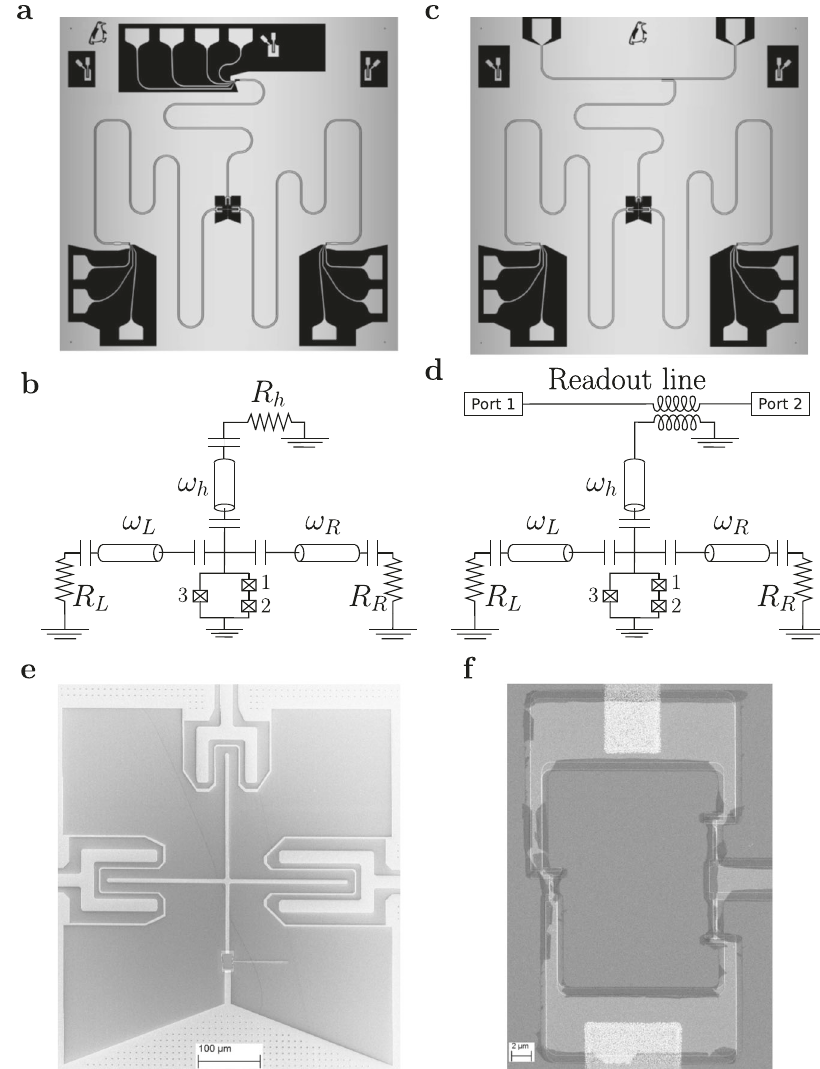
Fig. 2 Diagrams of the samples with qubits used for the heat transport and transmission coef fi cient measurements. Images of the sample I used in the heat transport experiment ( a ) and of the sample II used for the microwave spectroscopy ( c ). Both samples contain a cross-shaped Xmon-type superconducting qubit, which is capacitively coupled to three superconducting coplanar waveguide resonators. Samples size 7 × 7 mm. b Equivalent lumped-element circuit of the sample I and ( d ) of the sample II. e Scanning electron micrograph of the Xmon qubit island (scale bar: 100 μ m) and ( f ) of the fl ux qubit loop with three Josephson junctions (scale bar: 2 μ